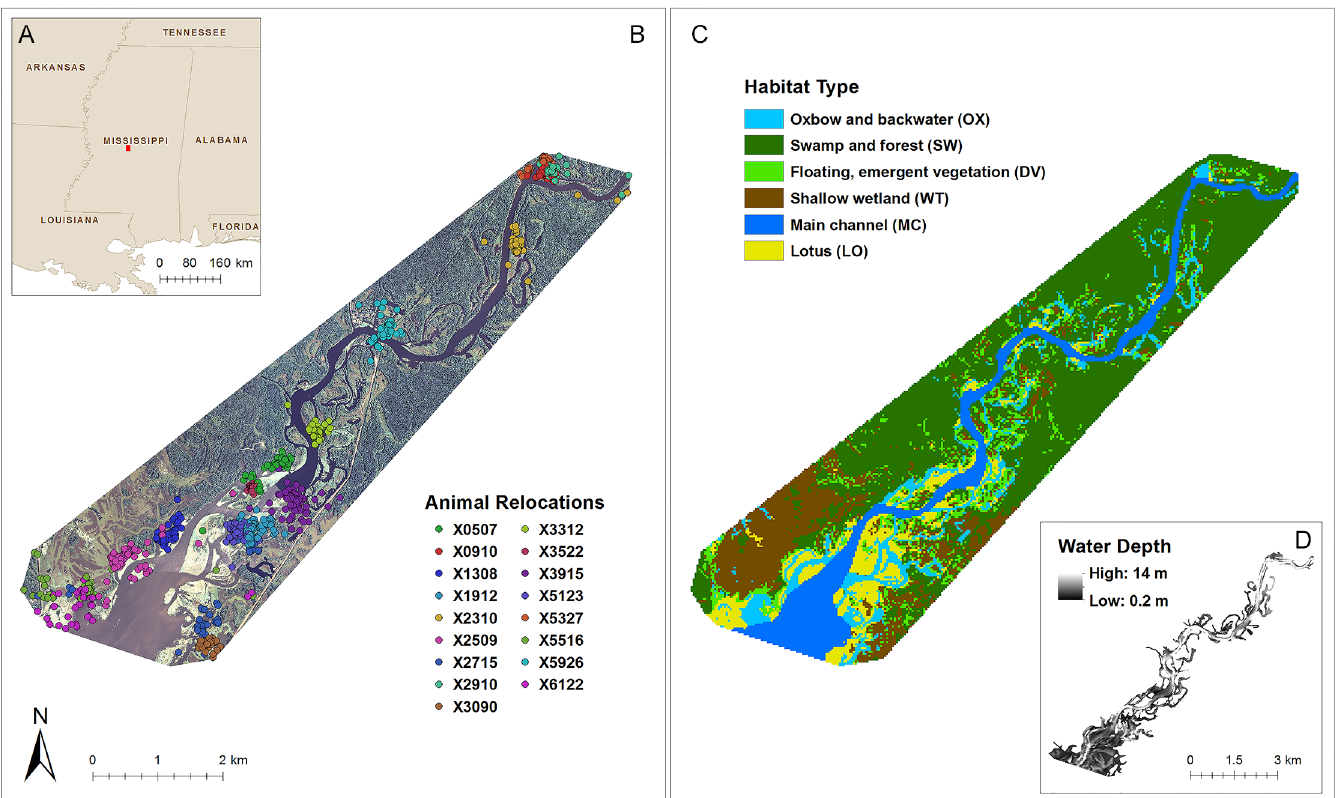
Fig 1. Map of the study area and radio-tracked adult male alligator relocations at Ross Barnett Reservoir and the Pearl River, Mississippi, USA, 2012 – 2013. (A) Inset shows study area as a solid red square. (B) Aerial imagery with animal relocations for 2012 and 2013 combined. (C) Categorical map of the six habitat types classified from aerial imagery. (D) Bathometric display of study area. Outside the main channel and reservoir white represents “ no data ” and inside it represents the deepest